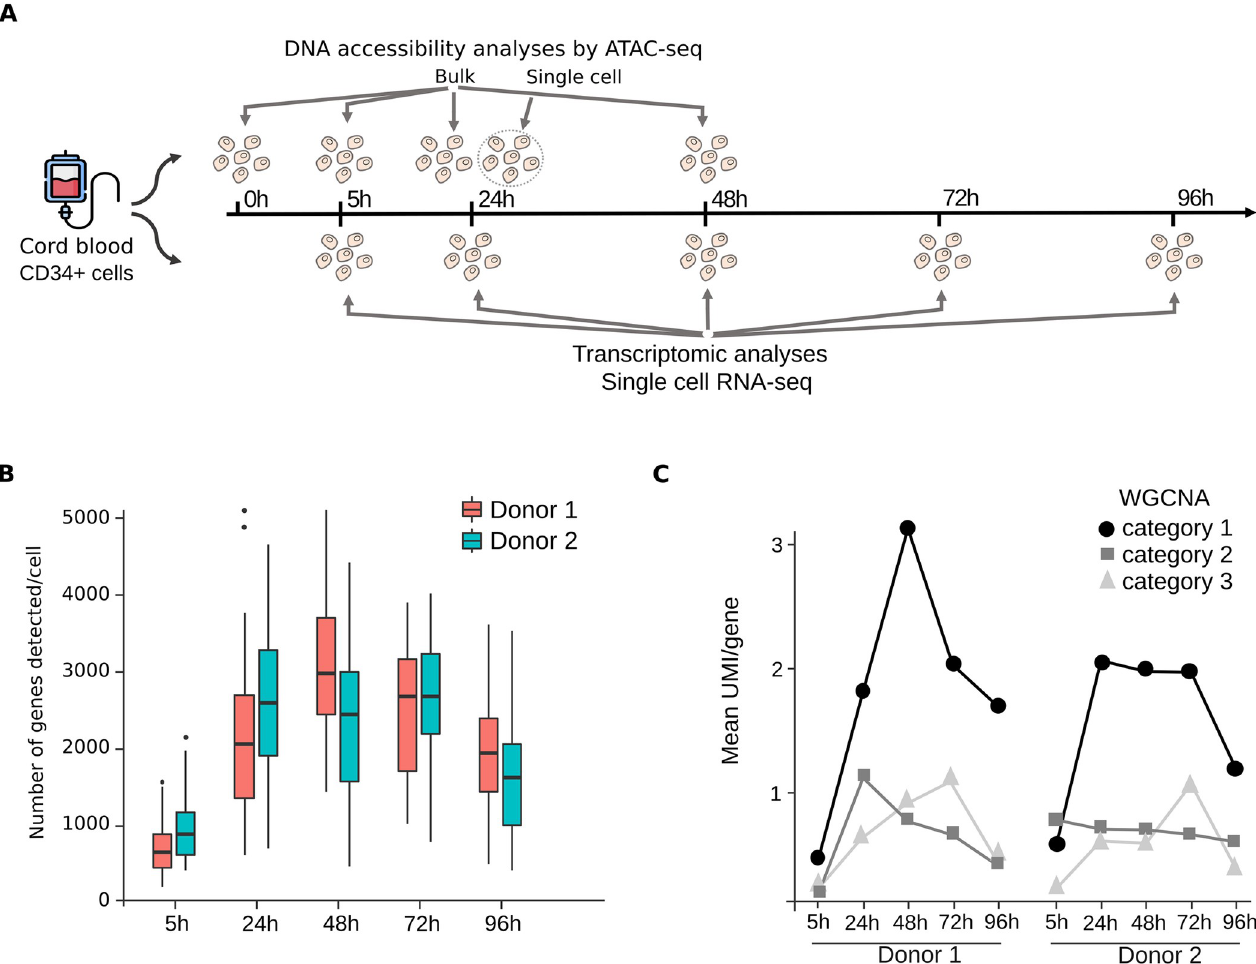
Fig 1. Experimental strategy and global gene expression dynamics. ( A ) CD34+ cells were isolated from human cord blood and cultured in serum-free medium with early acting cytokines. scRNA-seq was used to analyze transcription at 5 h, 24 h, 48 h, 72 h, and 96 h. Concomitantly, at 0 h, 5 h, 24 h, and 48 h, 5,000 living cells were collected for “bulk” ATAC-seq analysis of the DNA accessibility. The 24-h time point was analyzed by scATAC-seq also. ( B ) Number of detected genes per cell with scRNA-seq. Two donors were analyzed separately, both showed similar dynamics. The exact numbers are indicated in the Results section. Note the rapid increase in the number of genes expressed per cell between 5 h and 24 h and the slow decrease after a plateau between 24 h and 72 h. ( C ) WGCNA reveals groups of genes with similar dynamic patterns in the average mRNA expression in donor1 and donor2. Details about WGNCA are given in Materials and methods. Note that category 1 reproduces the best overall dynamic pattern observed for genes showing detectable expression in single cells in ( B ). Category 1 = 5,194 genes (donor1) and 5,518 genes (donor2), category 2 = 3,977 genes (donor1) and 2,602 (donor2), category 3 = 1,089 genes (donor1) and 609 genes (donor2). (Numerical values available in scRNA-seq repository GSE156734: “GSE156734_Spread_MARSseq_data_all_filters_20200728.csv”) scATAC-seq, single-cell ATAC sequencing; scRNA-seq, single-cell RNA sequencing; WGCNA, weighted correlation network analysis.